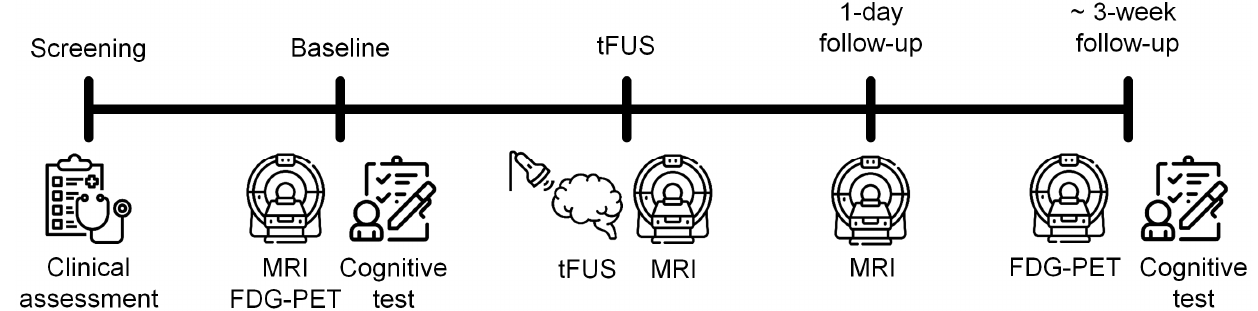
Figure 1. Study timeline. FDG–PET, 18 F-fluoro-2-deoxyglucose positron emission tomography; MRI, magnetic resonance imaging; tFUS, transcranial focused ultrasound.